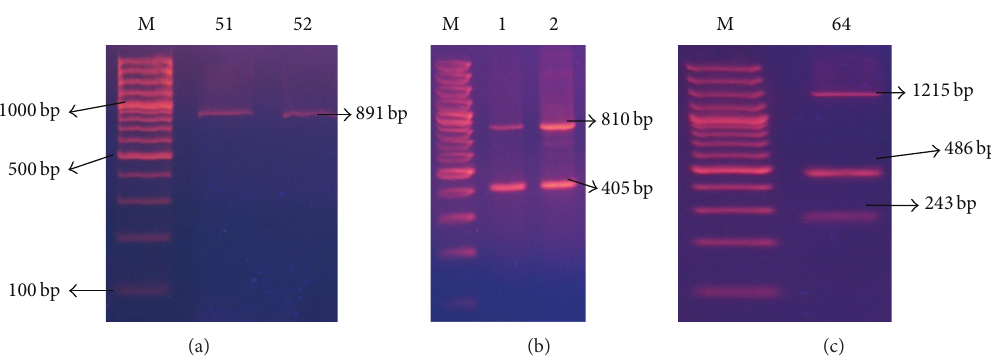
Figure 2: Representative 2% agarose gel electrophoresis of coa gene PCR products where M is DNA molecular size marker (100bp ladder), (a) isolates 51-52 showing single band, (b) isolates 1-2 showing 2 bands, and (c) isolate 64 showing 3 bands coa gene PCR products.